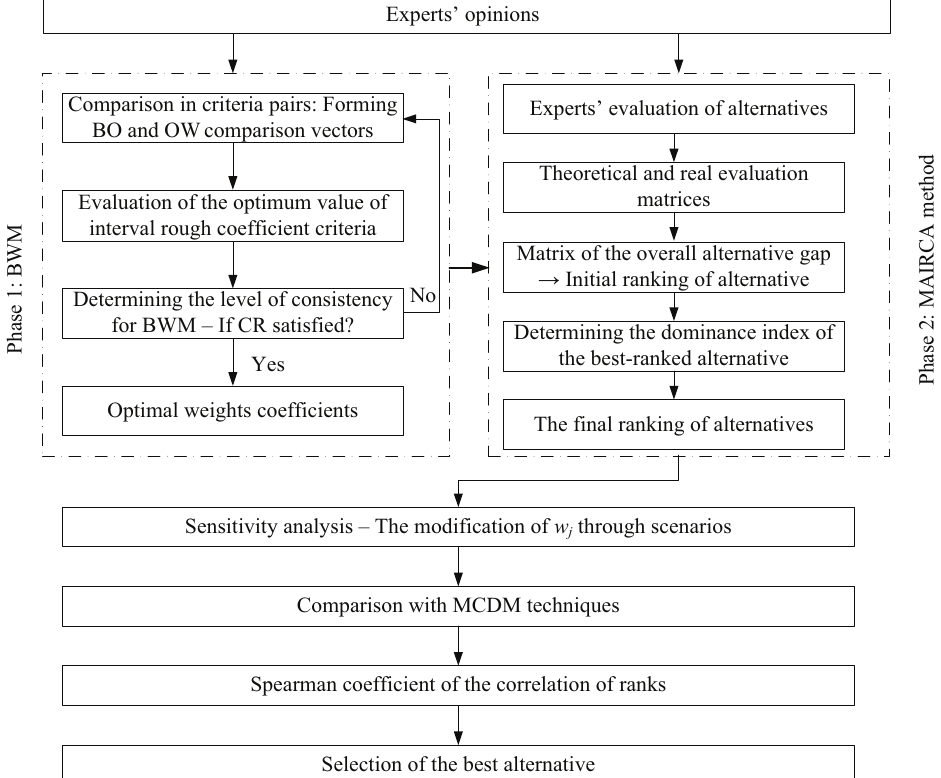
Figure 1. The framework of the proposed